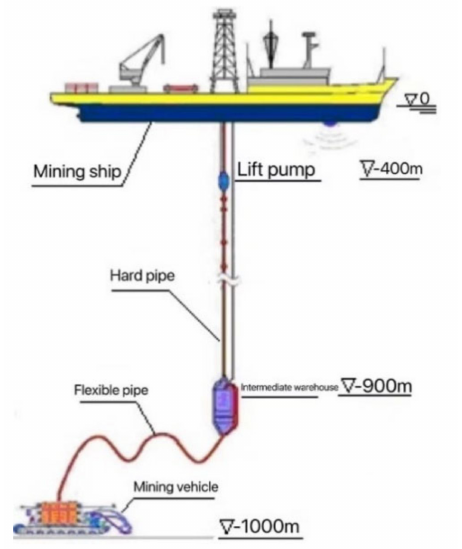
Figure 1. Chinese mining system